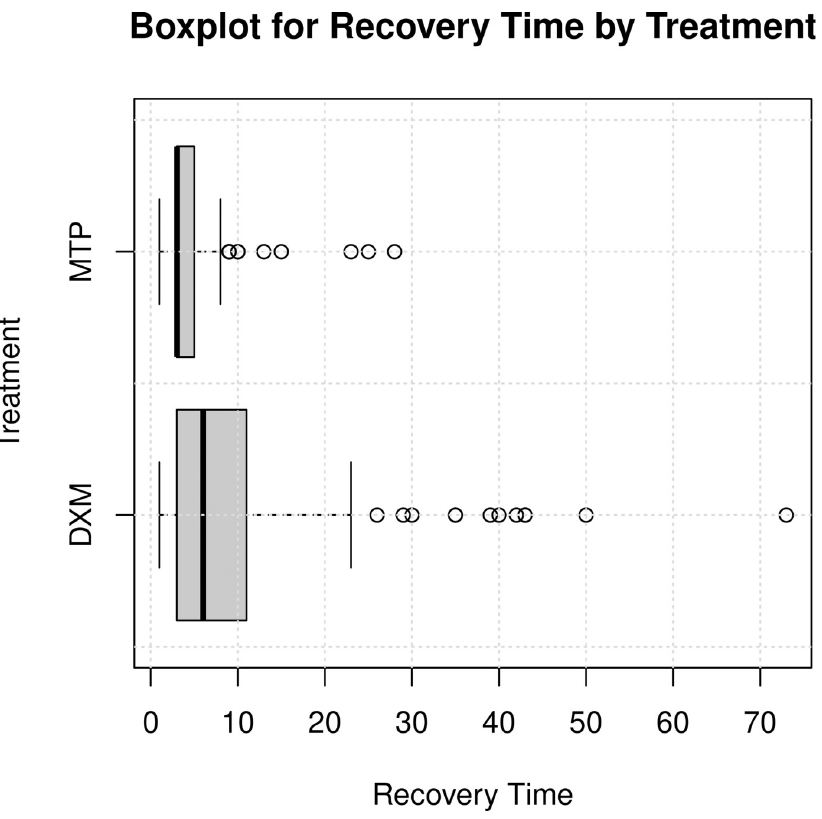
Fig 2. Recovery time according to the treatment received: Dexamethasone vs. methylprednisolone.